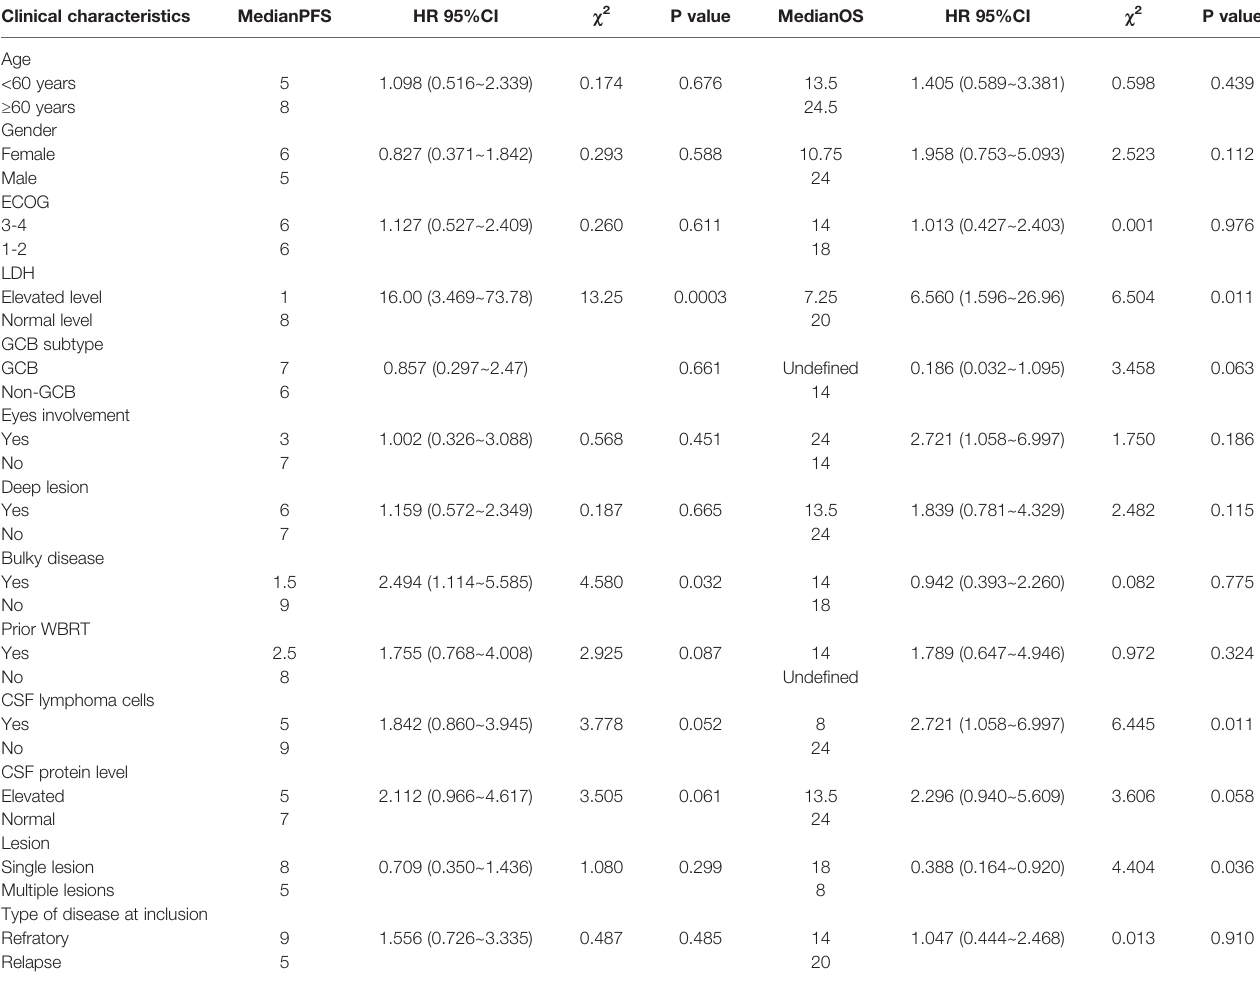
TABLE 4 | Univariate analysis of PFS and OS time in 38 patients with R/R PCNSL. Clinical characteristics